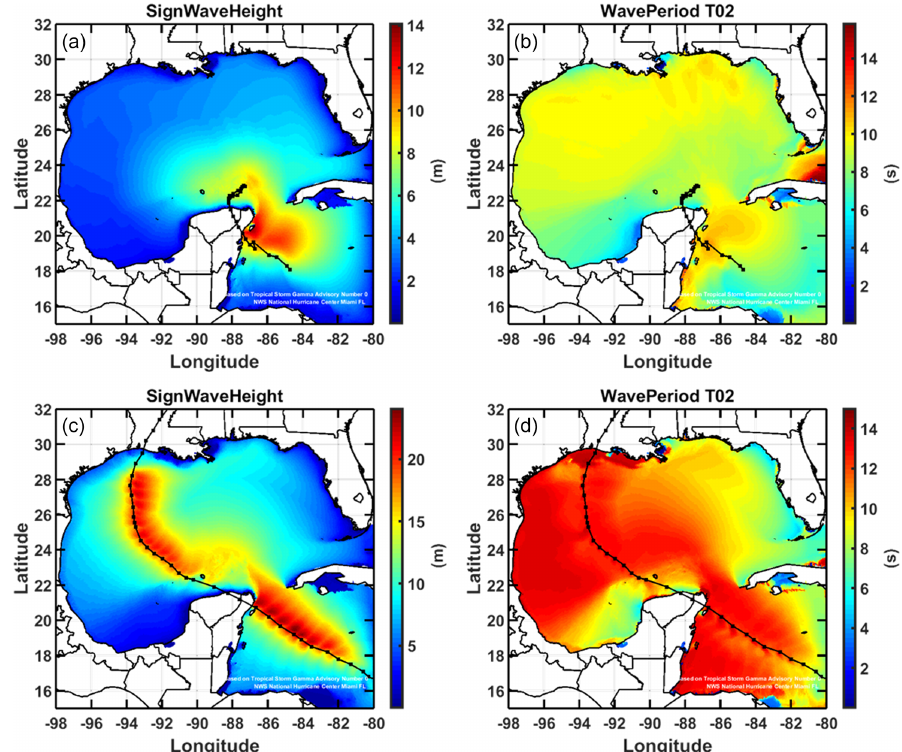
Figure 13. Envelopes of (a, c) maximum significant wave height and (b, d) maximum mean wave period, for both events: (a, b) Gamma and (c, d) Delta.